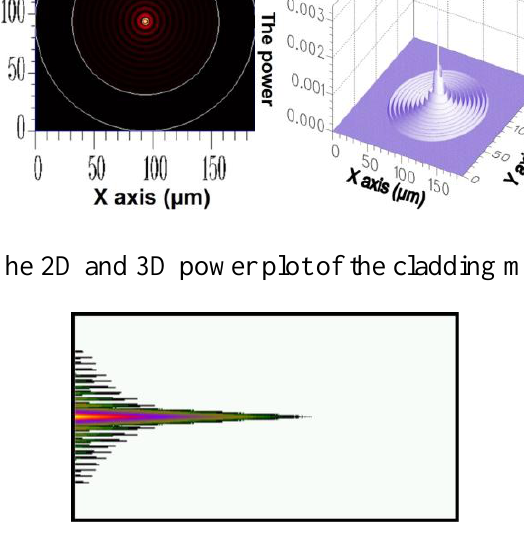
Figure 23. Plot between the orthogonal values of the 50 guided modes with N = 120,000, Λ = 0.53537 μm, L = L